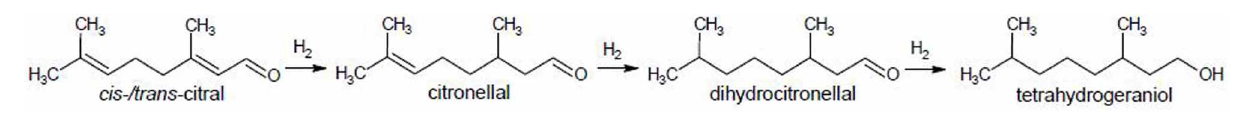
FIGURE 4 | Citral hydrogenation reaction sequence using alkaline ionic liquids in supported ionic liquid catalysts.